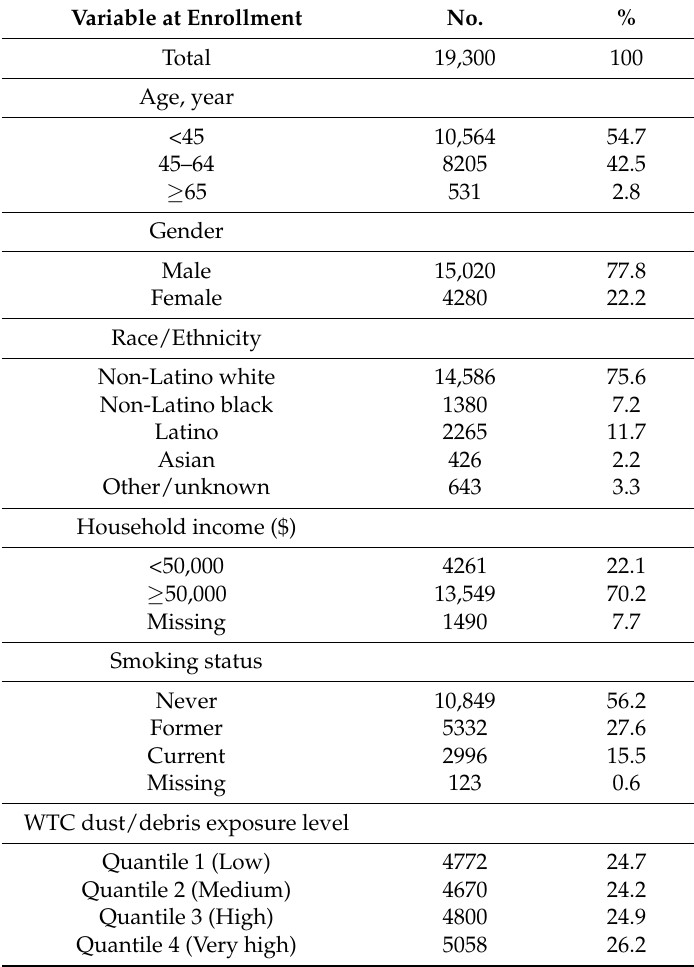
Table 1. Characteristics and World Trade Center (WTC) dust exposure of study sample at